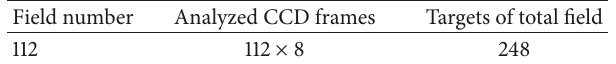
Table 3: Parameters of frame raw.